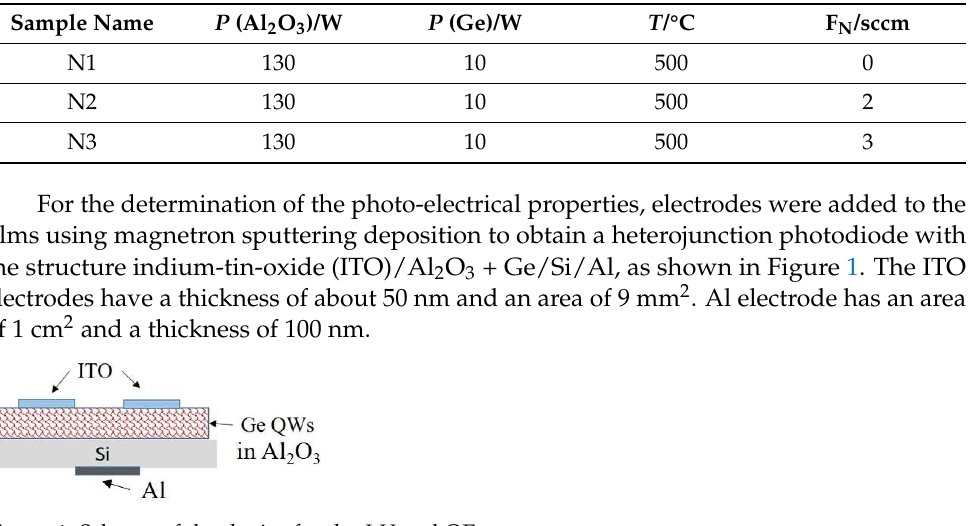
Figure 1. Scheme of the device for the I-V and QE measurements.